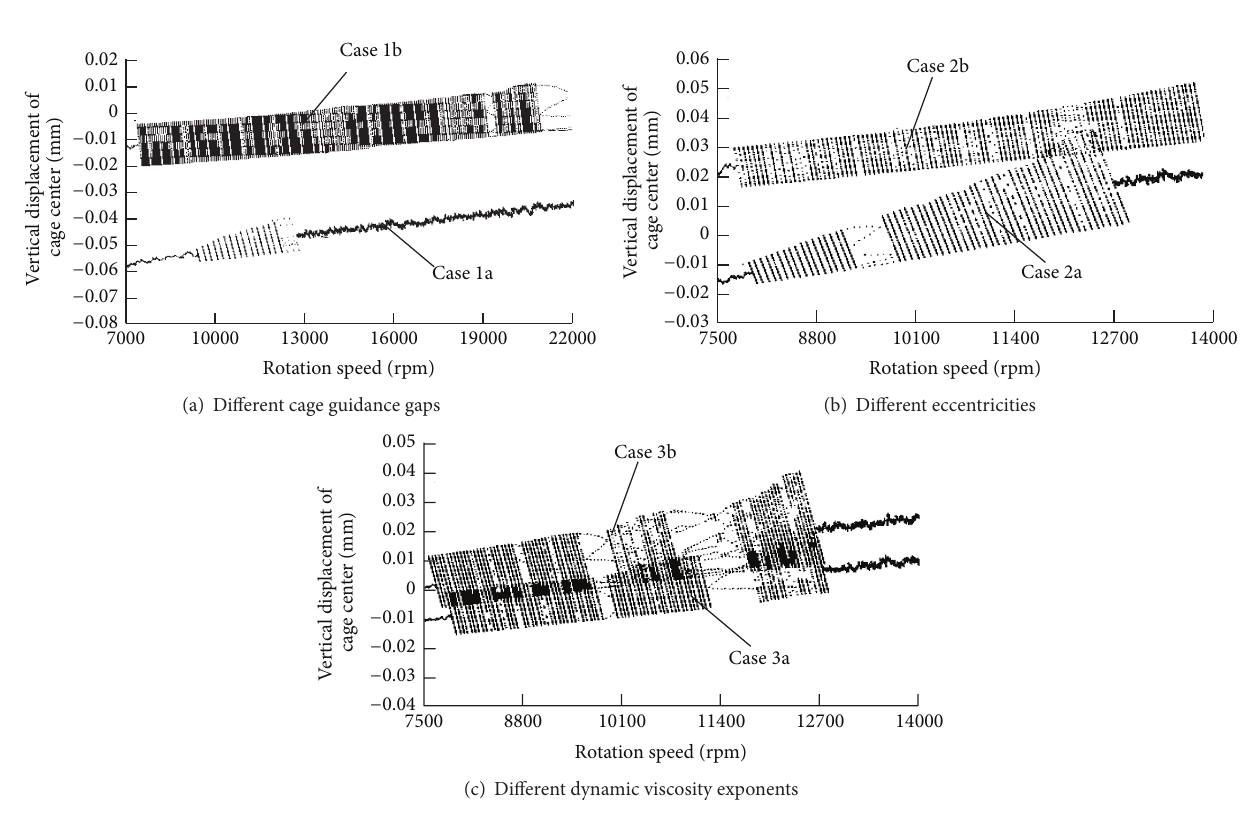
Figure 8: The first bifurcation zone from Figure 7 in enlarged